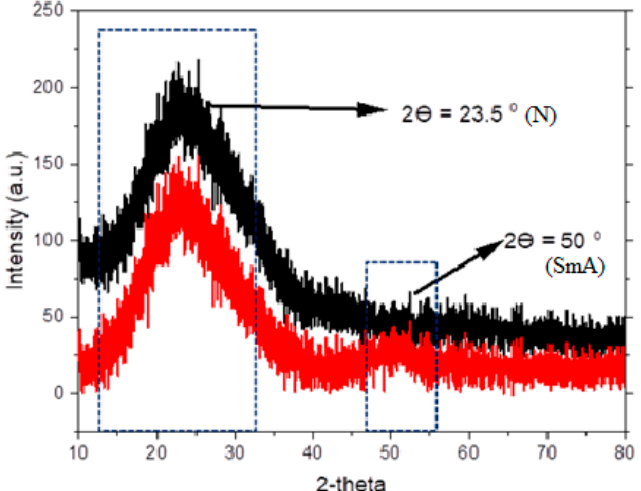
Figure 9. X-ray di ff raction patterns of A / 2B10 at di ff erent temperatures upon cooling from the isotropic Figure 9. X-ray diffraction patterns of A/2B10 at different temperatures upon cooling from the liquid isotropic liquid phase.